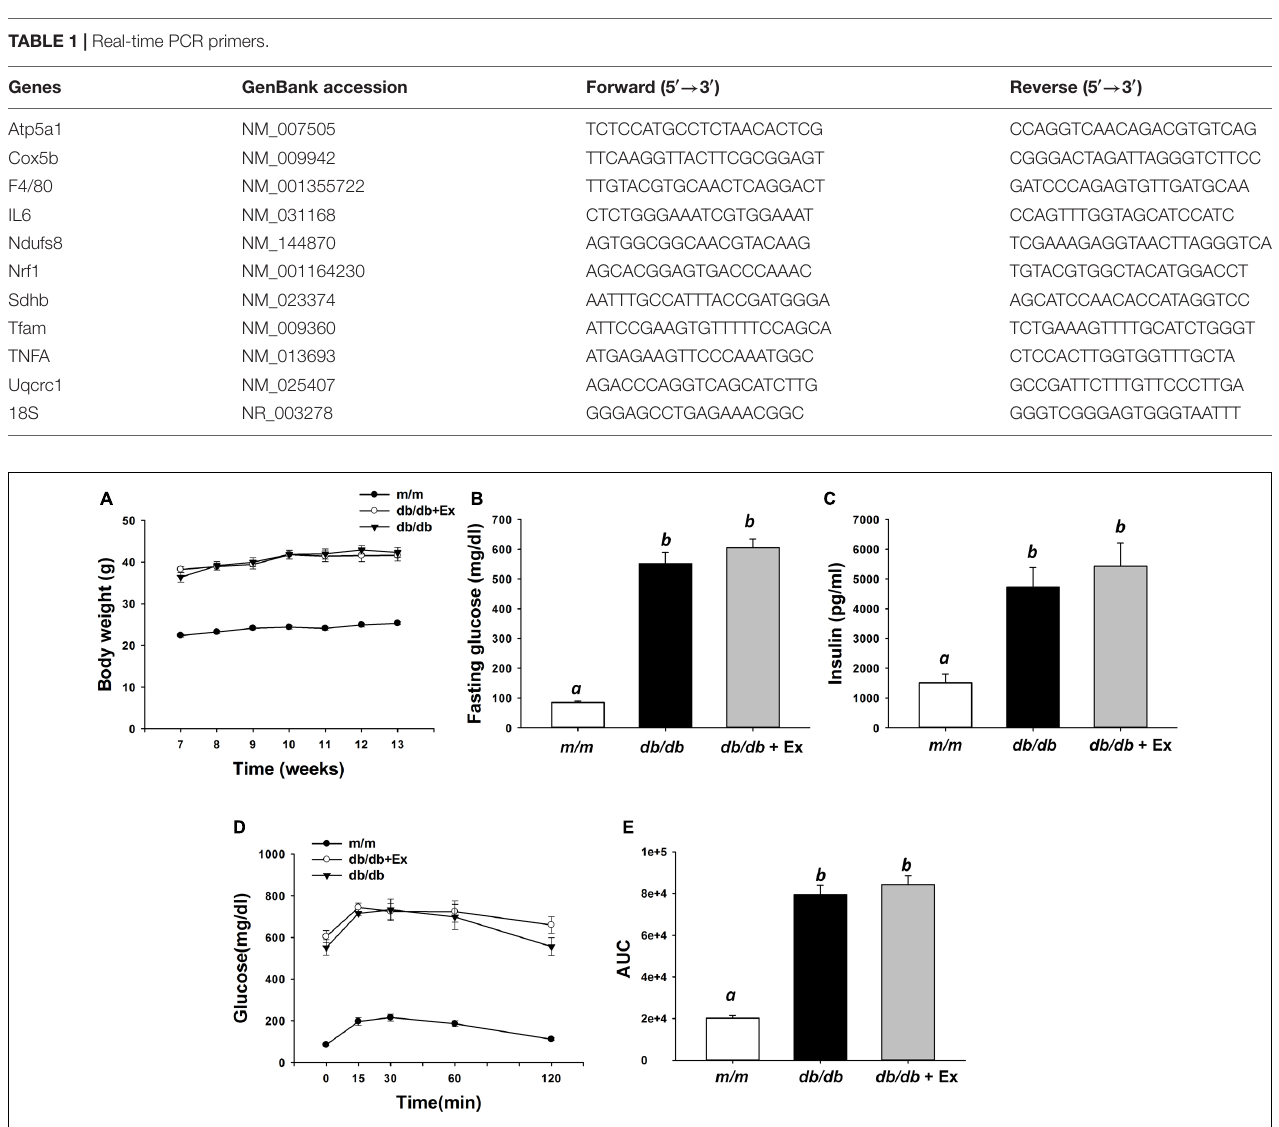
FIGURE 1 | Effect of moderate exercise training on body weight body, blood glucose, insulin, and glucose tolerance. Body weight ( A , n = 11–12/group), fasting glucose ( B , n = 6/group), serum insulin ( C , n = 11–12/group), IPGTT ( D , n = 6/group), and area under the curve (AUC) calculations ( E , n = 6/group) in m/m , db/db , and db/db +Ex groups. Values presented are mean ± SEM. Significance ( P < 0.05) among groups is denoted by different letters.